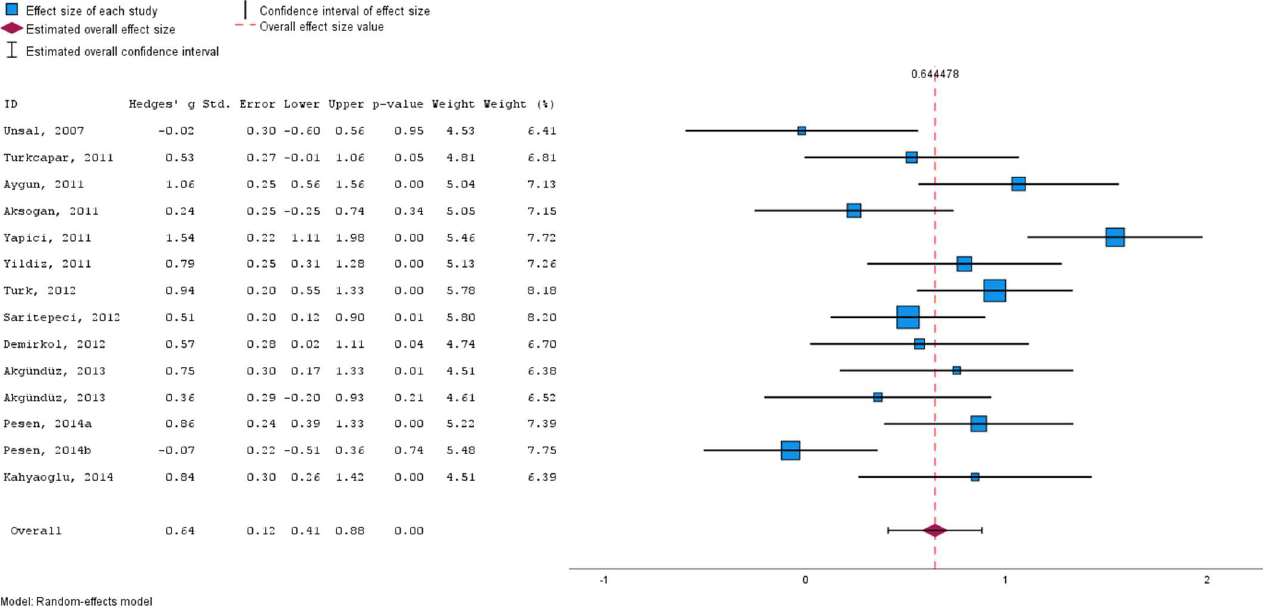
Figure 8. Forest Plot. Table 3. Sample data set for binary meta-analysis [52].